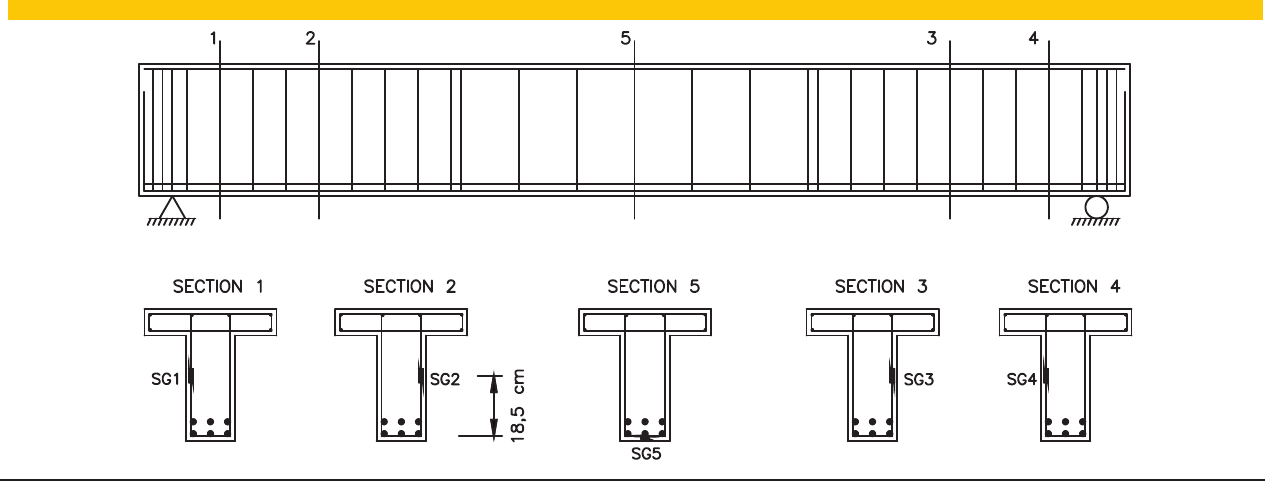
Figure 7 – General view of strain gauge locations on steel stirrups and longitudinal bar of series